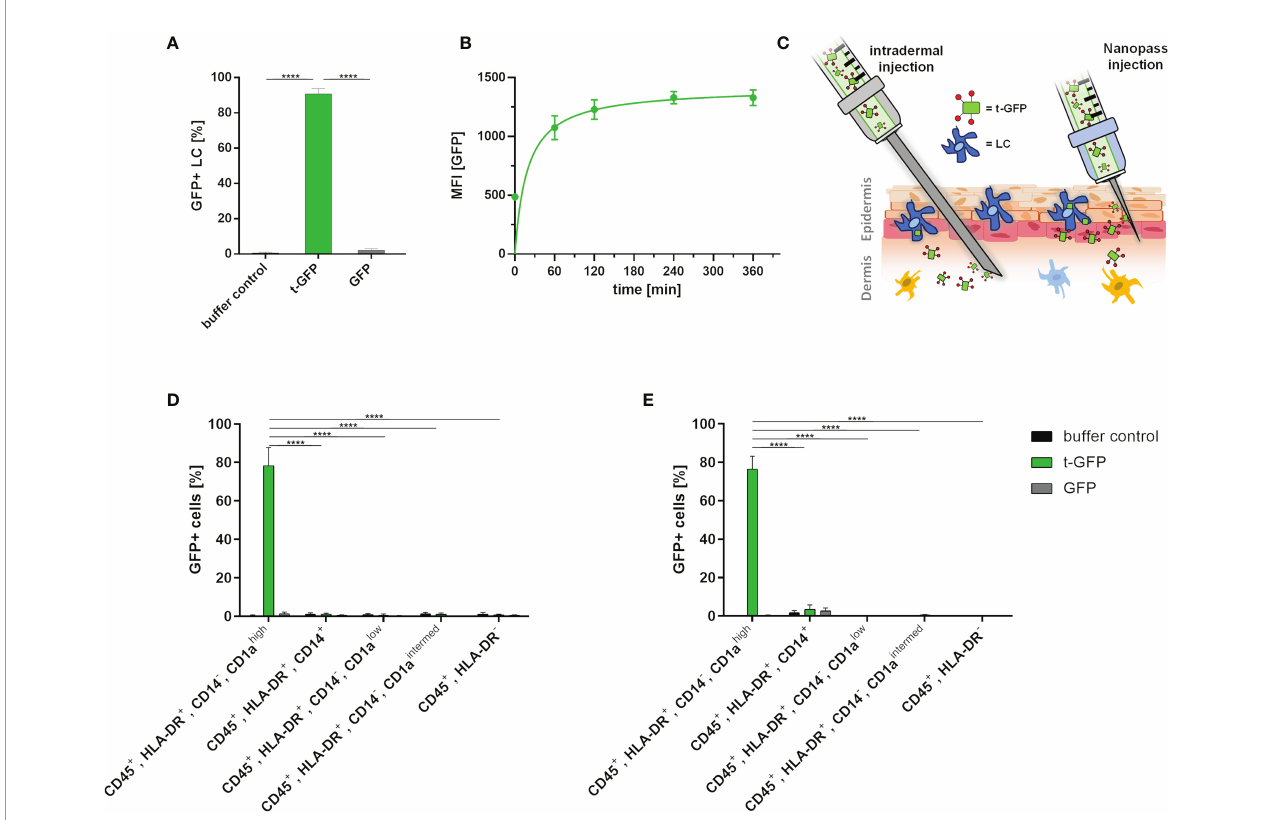
FIGURE 3 | t-GFP is speci fi cally taken up by LCs ex vivo . (A) fl ow cytometry analysis of t-GFP uptake by LCs in epidermal cell suspensions. n = 4 (B) kinetic analysis of t-GFP uptake into LCs puri fi ed via CD1a-microbeads. (C) schematic illustration of different administration routes for LC targeting in intact human skin. (D, E) speci fi c uptake of t-GFP into LCs upon (D) intradermal (n = 3) and (E) NanoPass injection (n = 3). LCs were identi fi ed as (A) single, live, CD45 + , HLA-DR + , Langerin + (D, E) single, live, CD45 + , HLA-DR + , CD14 - , CD1a high . ****p-value < 0.0001, two-tailed, unpaired